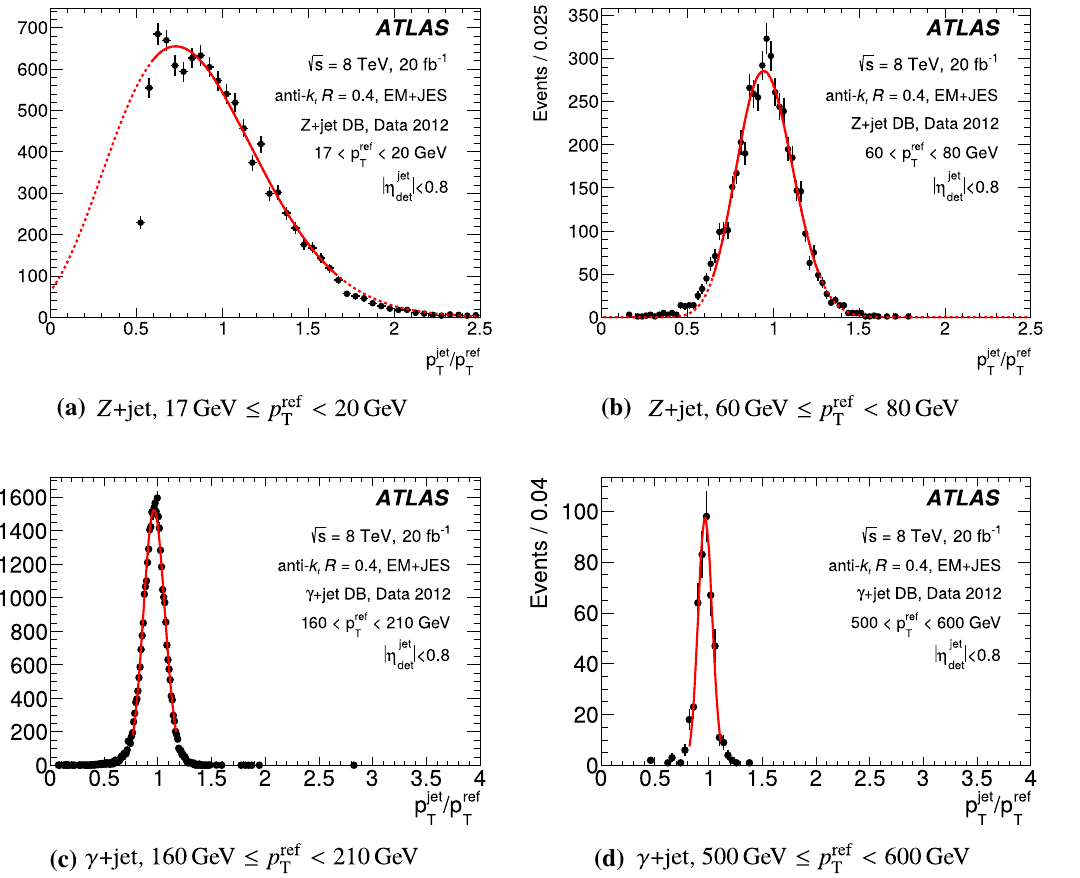
/ p ref visible in a is due to the T T